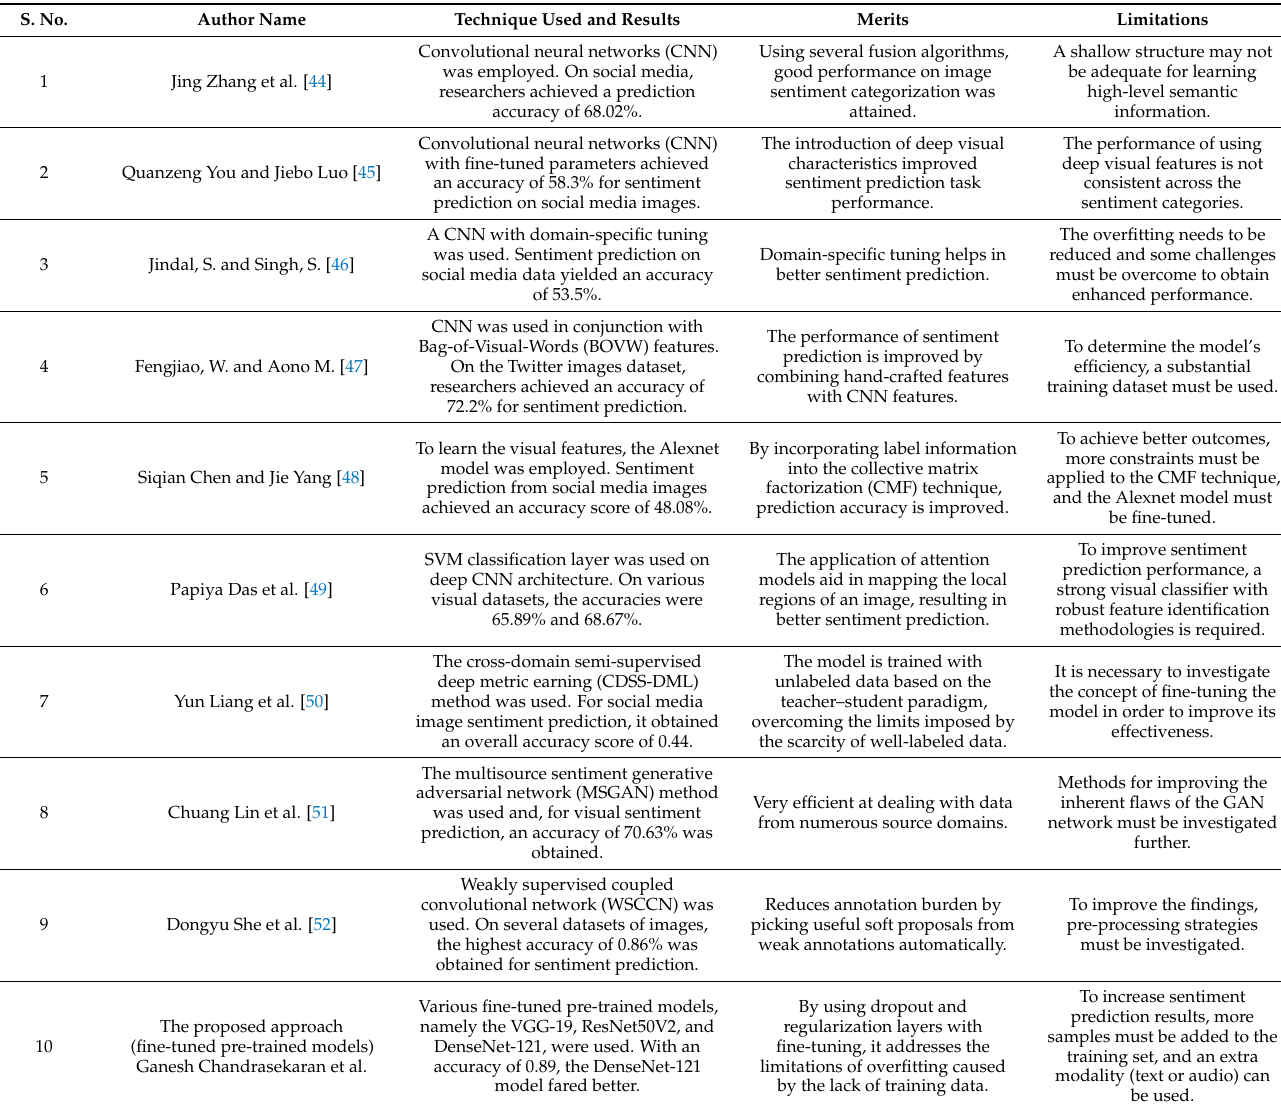
Table 8. Comparison of existing works with our image sentiment analysis